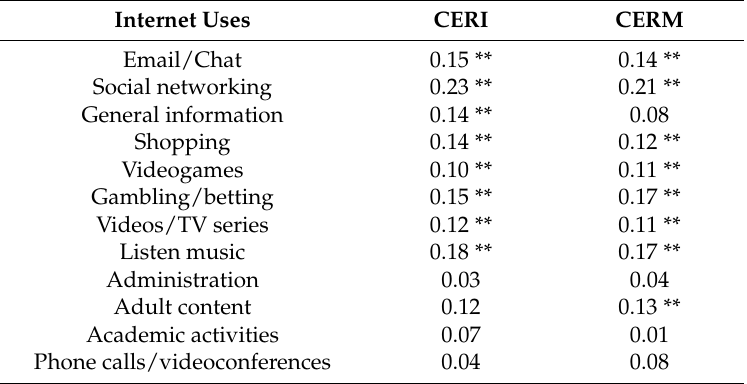
Table 3. Correlations between CERI or CERM and the uses of the Internet.